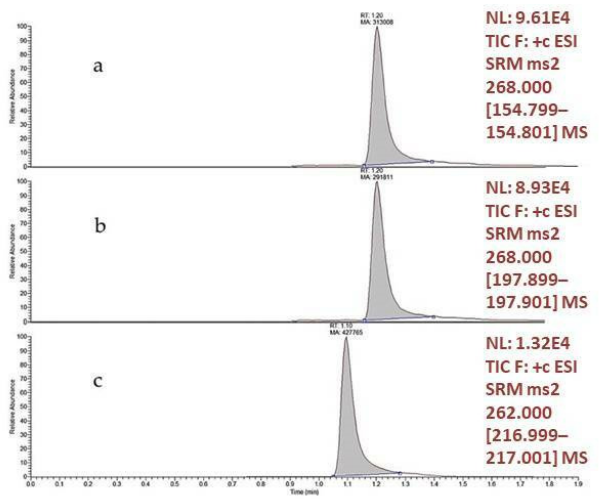
Figure 2. Chromatographic profile of CNB: ( a ) quantifier transition; ( b ) qualifier transition; and the internal standard ( c ).